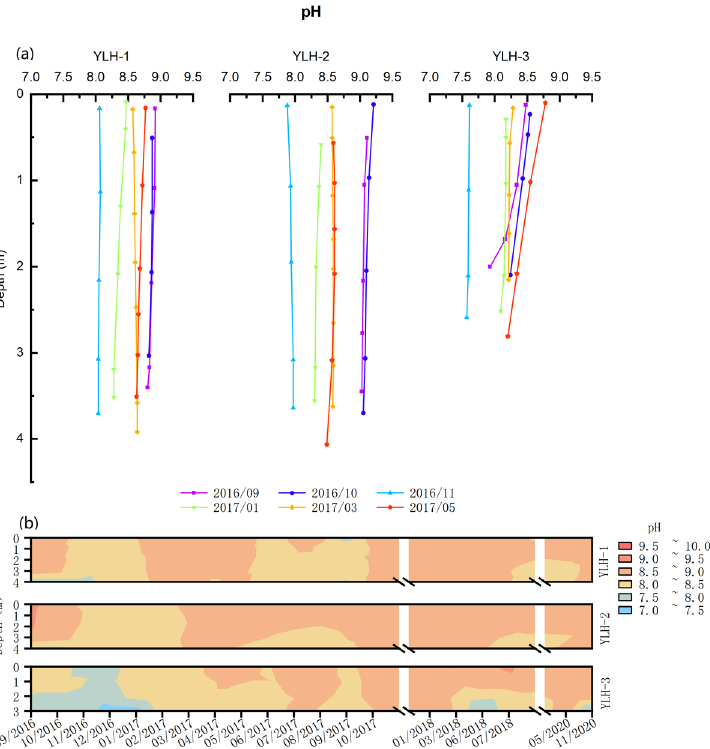
Figure 6. Seasonal and interannual variations in pH in lake Yilong. ( a ) Seasonal variations in water temperature; ( b ) Interannual variations in water temperature.